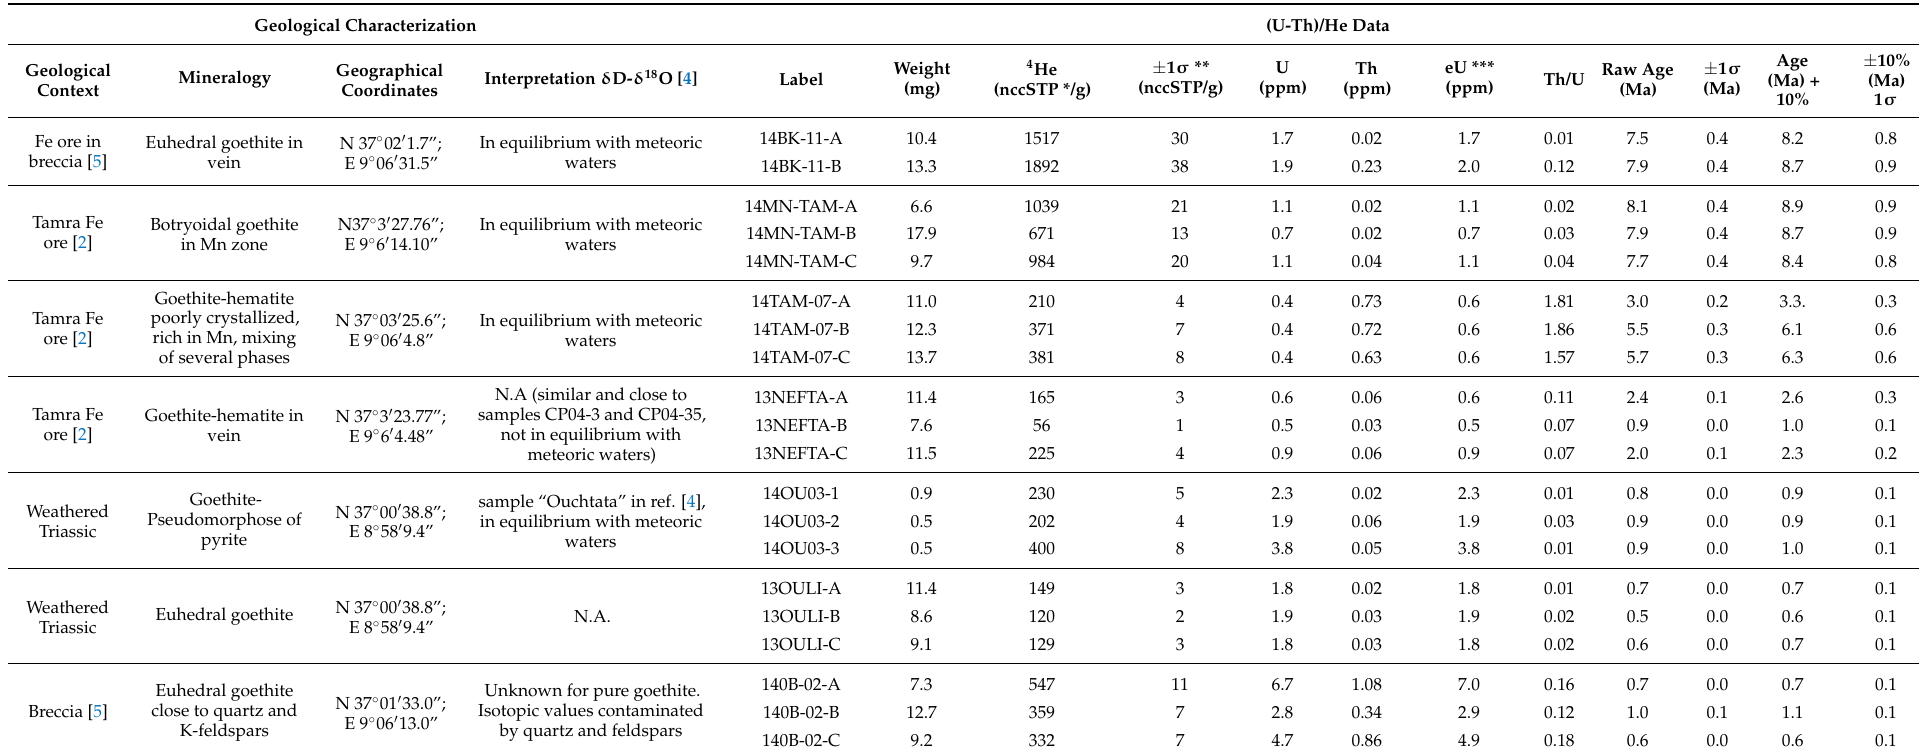
Table 1. Sampling site, geological characterization, and (U-Th)/He data of analyzed samples. N.A. = not